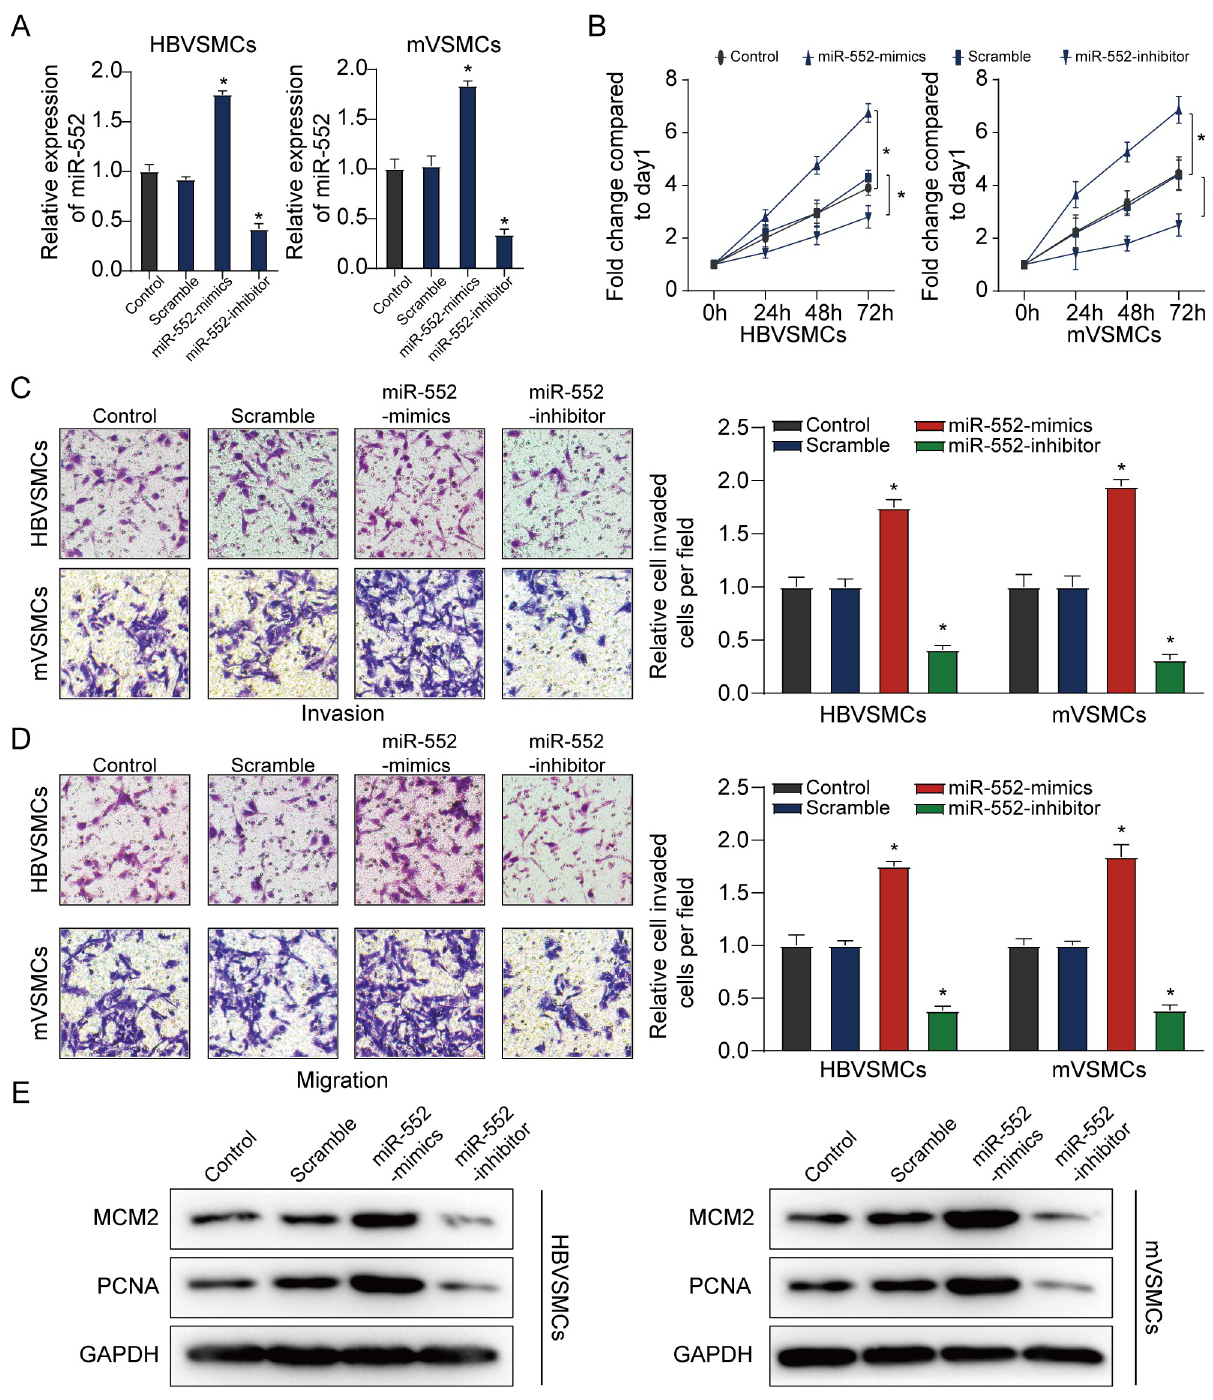
Fig 2. MiR-552 facilitates proliferation, invasion and migration of HBVSMCs. (A ) qRT-PCR assay was used to measure miR-552 expression in HBVSMCs and mVSMCs transfected using miR-552 mimics or inhibitor. ( B ) The MTT assay was applied to assess proliferation ability of HBVSMCs and mVSMCs transfected by miR-552 mimics, inhibitor, scramble or control. ( C, D ) The transwell assay was conducted to measure invasion and migration of HBVSMCs and mVSMCs transfected with miR-552 mimics, inhibitor, scramble or control, respectively. (E) Western blot assay was used to detect the protein level of PCNA and MCM2 in HBVSMCs and mVSMCs transfected with miR-552 mimics, inhibitor, scramble or control, respectively. (Student’s t test). � P < 0.05. ns: No significance.